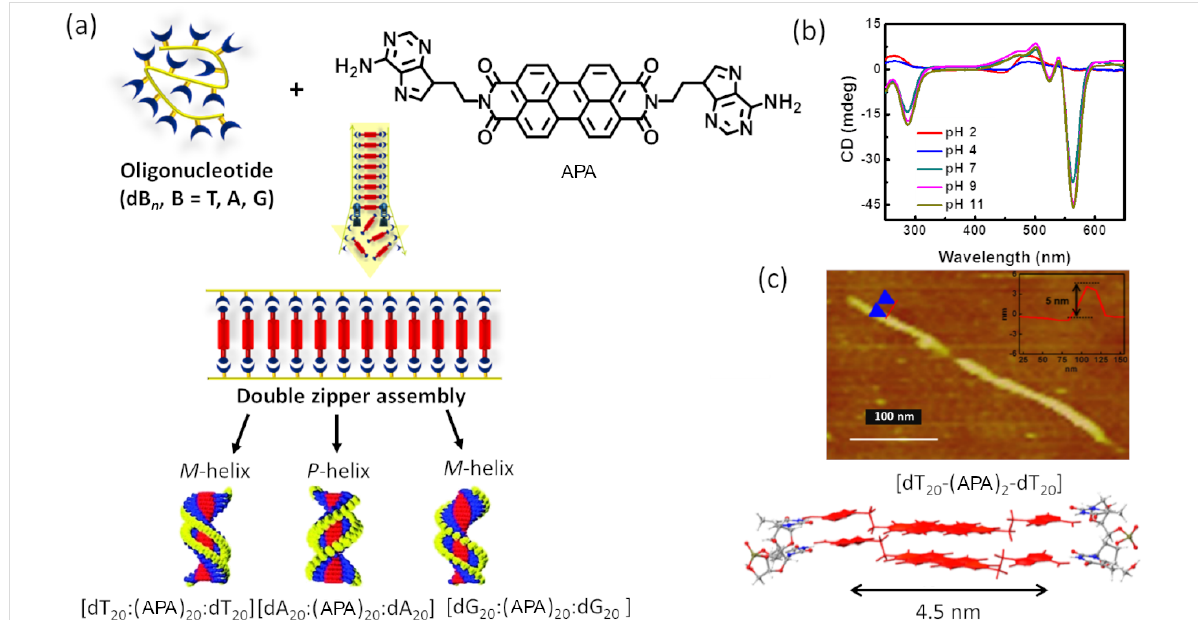
Figure 4: a) Schematic representation of mutually templated double-helical zipper assemblies of APA and dB n (B: nucleobases T, A, or G; n =10, 20) via canonical and noncanonical hydrogen bonding interactions. b) pH-dependent CD measurement of double-helical zipper ensembles. c) AFM image